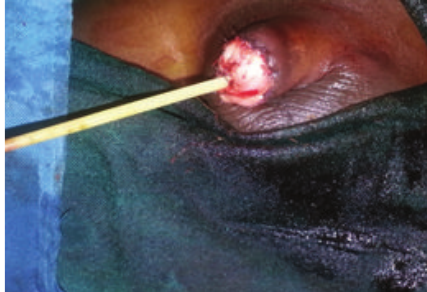
Figure 5: Oral mucosa used to graft the raw area of the corporeal bodies.